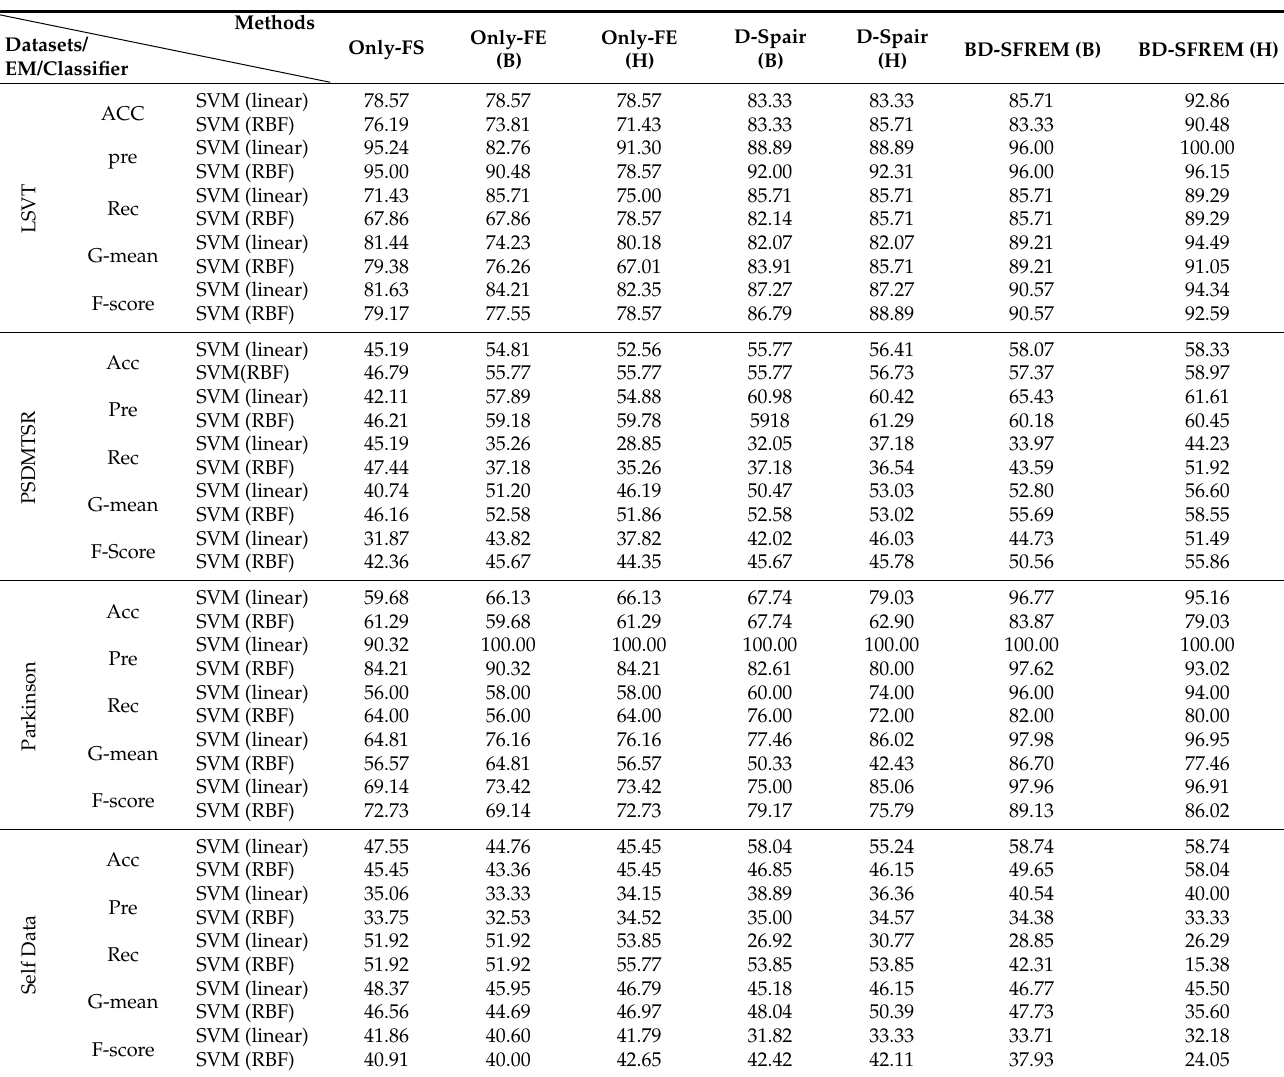
Table 4. Results of the validation of the algorithm using the ablation method